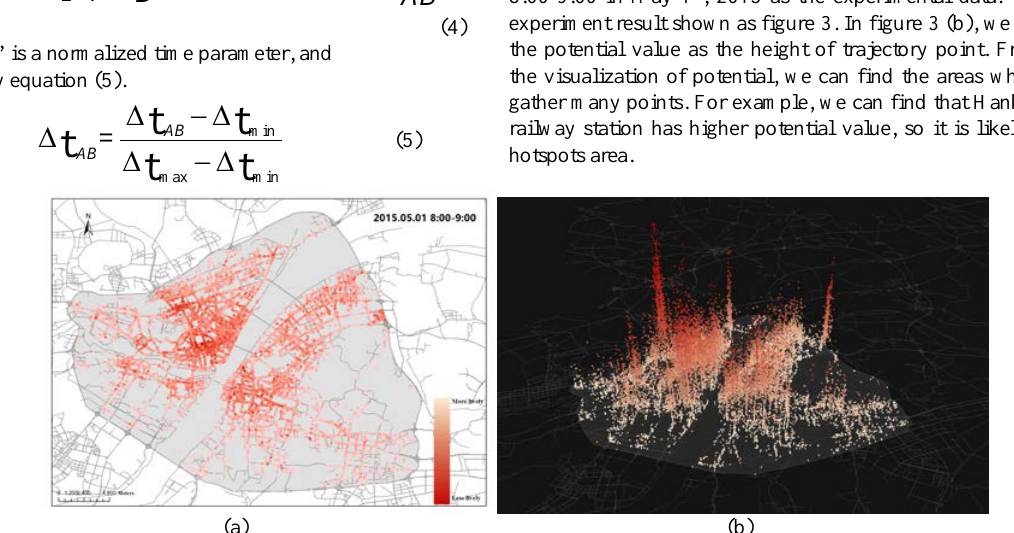
Figure 3. Visualization of potential. (a) Visualization of potential in 2d, (b) Visualization of potential in 3d.